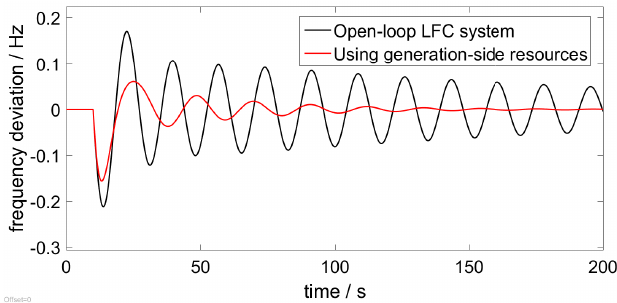
Figure 4. Frequency deviation of area 1 under generation-side